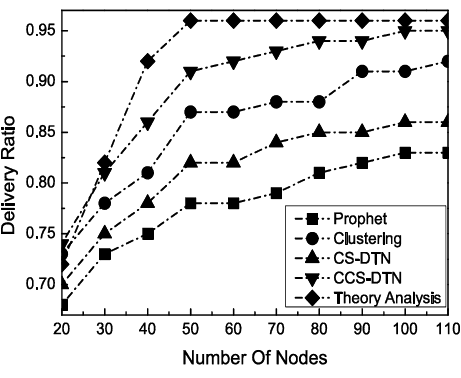
Figure 8. Impact of Number of Nodes on Delivery